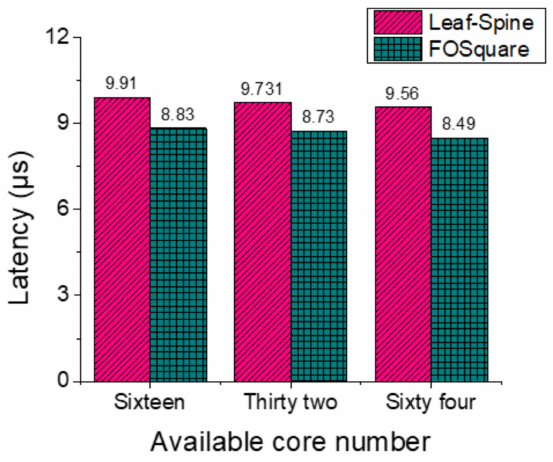
Figure 9. MINI_MD application